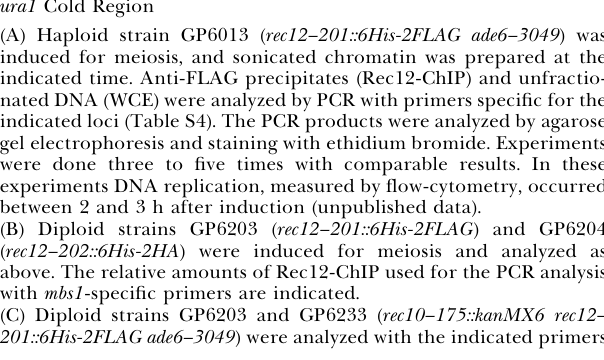
Figure S1. Meiosis-Specific Rec12-DNA Linkage Requires Rec10 and Is Abundant at the mbs1 and ade6–3049 DSB Hotspots but Not in the ura1 Cold Region (A) Haploid strain GP6013 ( rec12–201::6His-2FLAG ade6–3049 ) was induced for meiosis, and sonicated chromatin was prepared at the